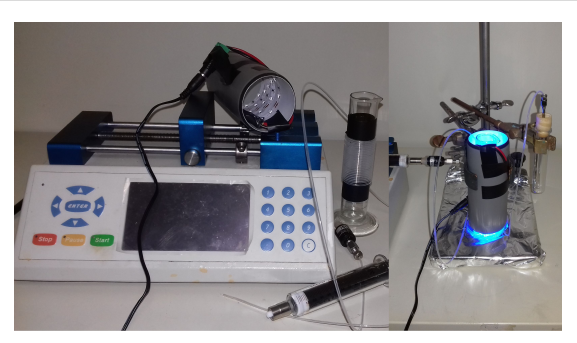
Figure 2: The meso-flow apparatus assembled in-house. The compo- nents are shown on the left, while the operating system is shown on the right.